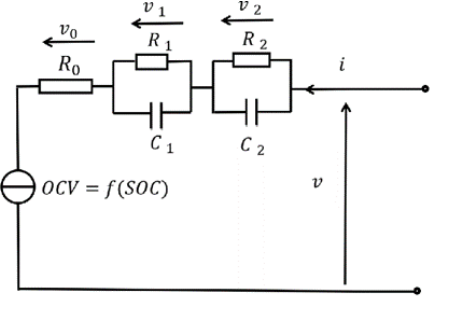
Figure 3. The Equivalent Circuit Model of lithium-ion battery with all model parameters which describe the operation of a single